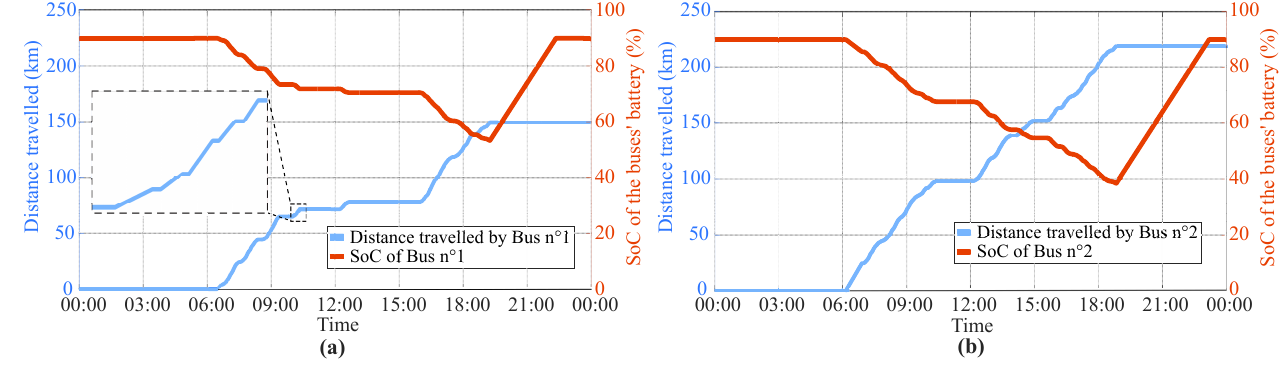
Figure 8. Travelled distance and battery SoC of buses n°1 ( a ) and n°2 ( b )—scenario 1.